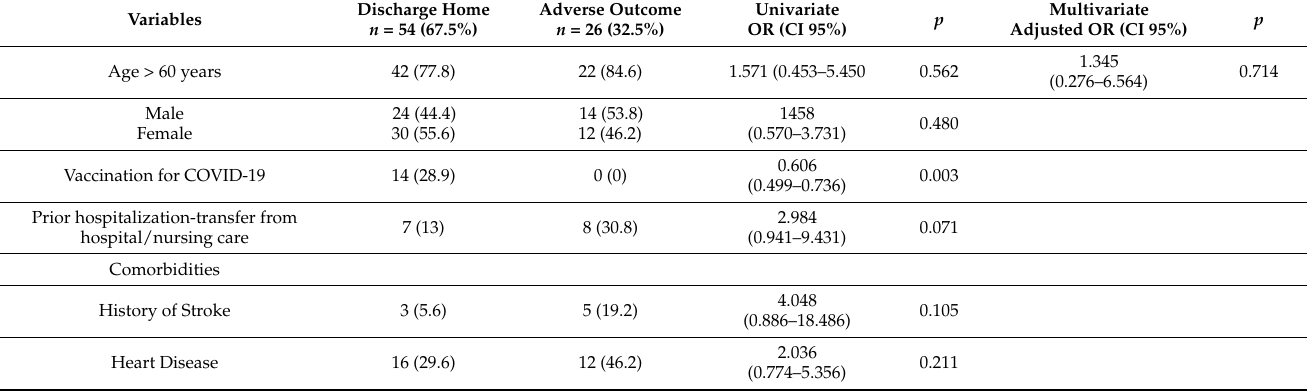
Table 3. Analysis of factors related to adverse outcome of COVID-19 patients in medical